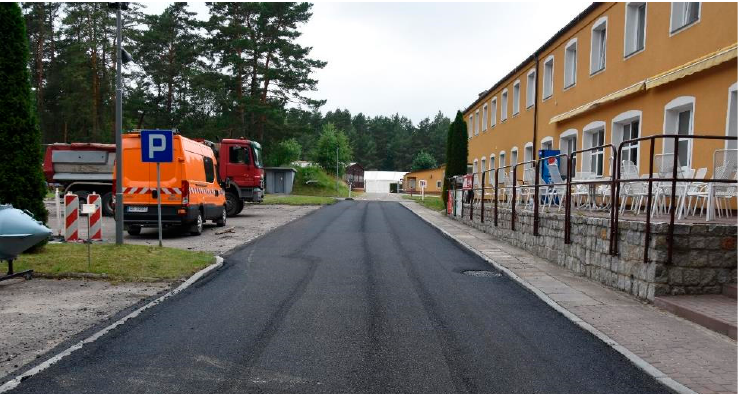
Figure 8. First short test section at the asphalt plant (MTM1) constructed during technological trials described in Section 3.6–September 2018.